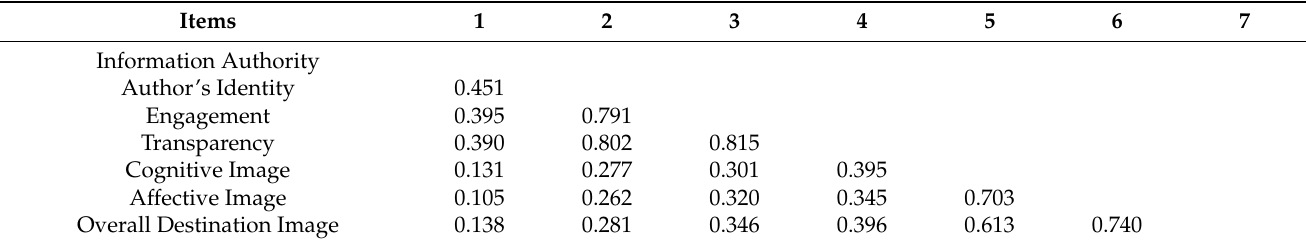
Table 4. Discriminant